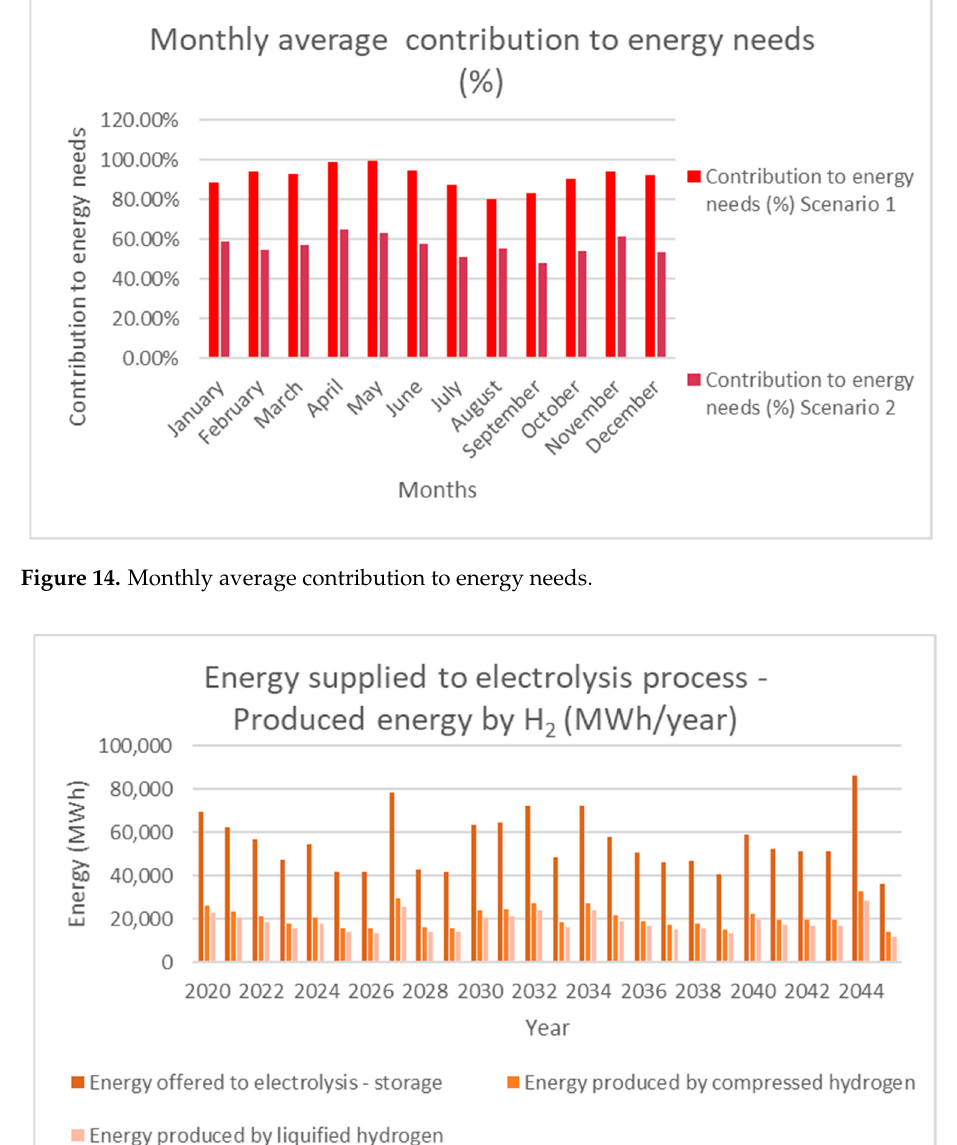
Figure 13. Contribution to energy needs per source using liquefied H 2 .